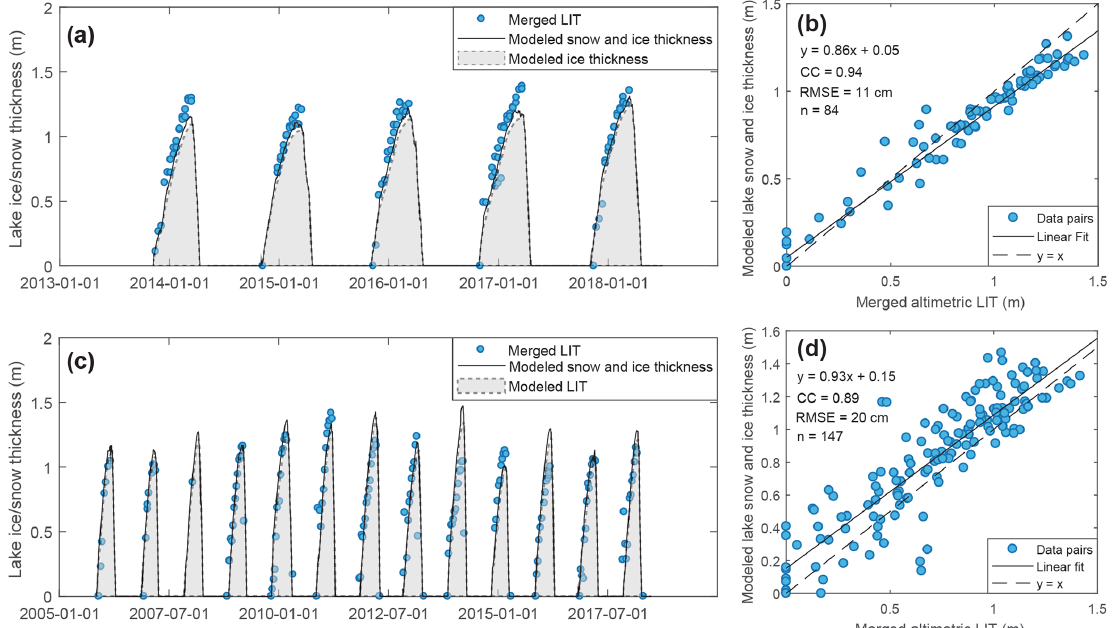
Figure 8. Cross-validation between the merged altimetric LIT (waveforms and backscattering-coefficient-based) and modeled lake snow and ice thickness. Panels (a) and (c) are time series for merged altimetric LIT and modeled lake snow and ice for Hulun Lake and Har Lake, where the blue dots denote merged altimetric LIT, shaded areas denote modeled LIT, and black curves denote modeled lake ice and snow thickness. Panels (b) and (d) are scatterplots for altimetric LIT and modeled lake ice and snow thickness for Hulun Lake and Har Lake, respectively.